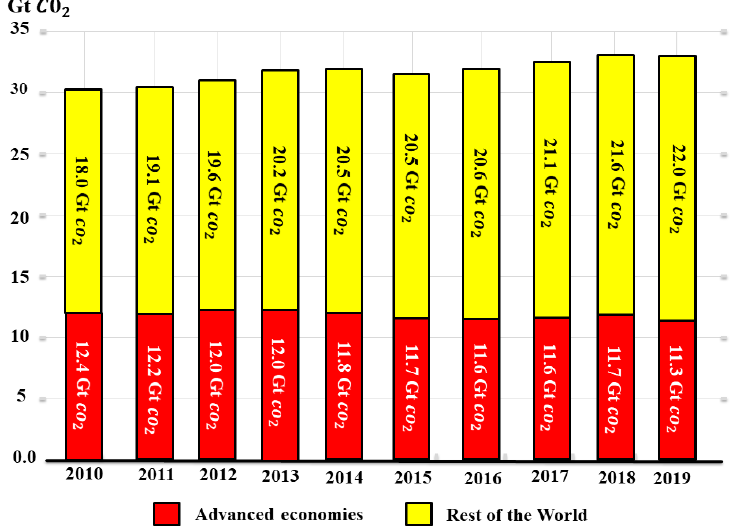
Figure 3. Energy-related CO ₂ emissions, 2010–2019